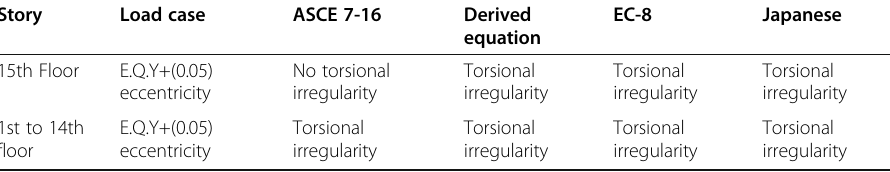
Table 13 Torsional irregularity check of 4th model due to ASCE 7-16, EC-8, Japanese, and derived equation